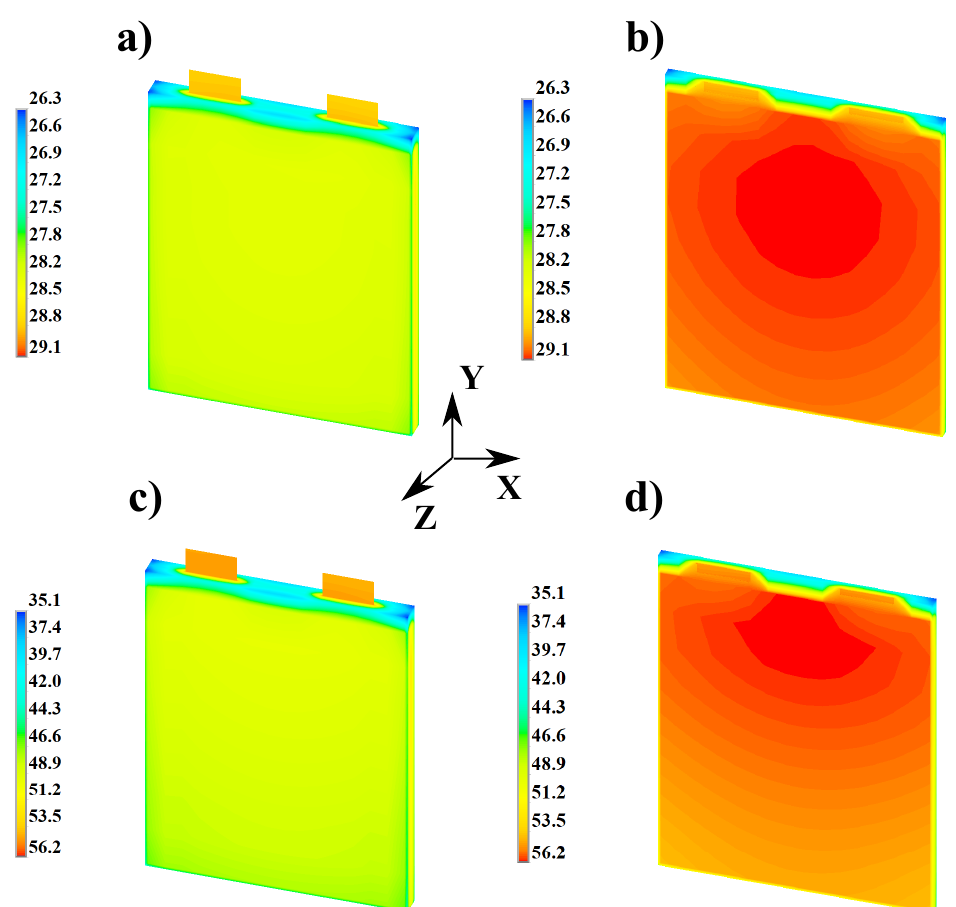
Figure 6. Temperature distribution profiles ( ◦ C ) of the investigated 12 Ah pouch cell at the end of discharge: ( a ) on the surface at 1C; ( b ) cross-sectional area in the center of the electro-active layers at 1C ( c ) on the surface at 4C; ( d ) cross-sectional area at the center of the electro-active layers at 4C. Initial SOC = 100%.